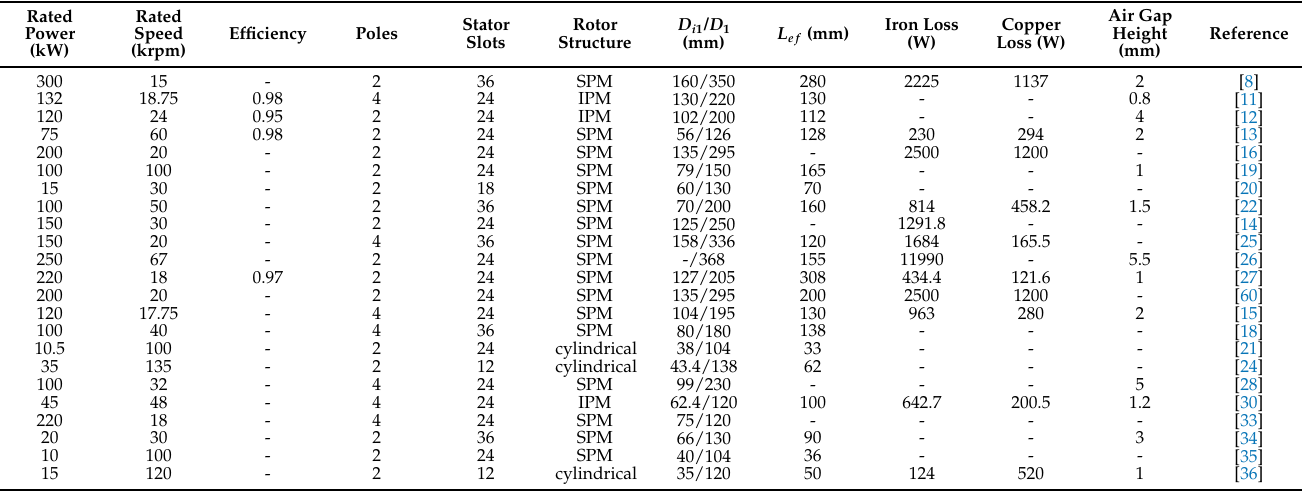
Table A1. Data resources for different dimensional parameters of high-speed permanent magnet motors with different